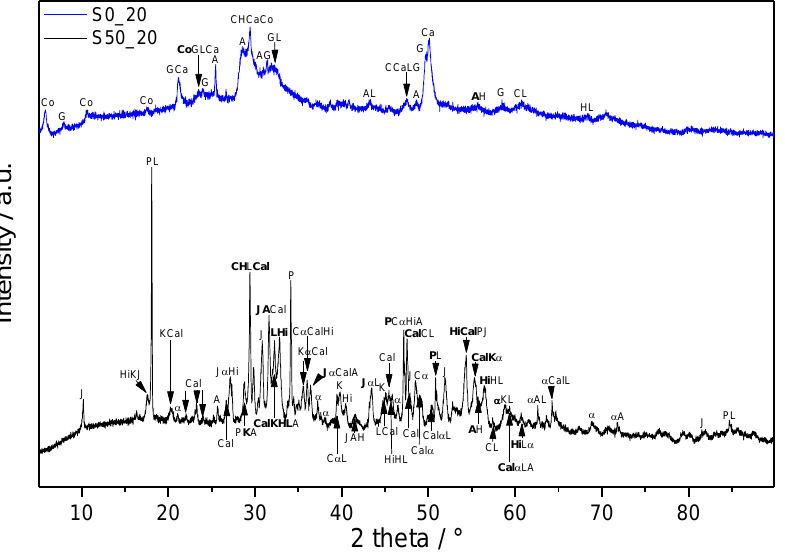
Figure 5. XRD patterns of samples cured at 2.0 MPa and 220 °C for 7 days. Abbreviations: α—α- dicalcium silicate hydrate (Ca 2 (SiO 3 OH)(OH), α-C 2 SH), A—anhydrite (CaSO 4 , CS ), C—calcite (CaCO 3 , C C̅ ), Ca—calcium hydrogen silicate (CaH 4 Si 2 O 7 , CS 2 H 2 ), Cal—calciochondrite (Ca 5 (SiO 4 ) 2 (OH) 2 , C 5 S 2 H), Co—cowlesite (CaAl 2 Si 3 O 10 · 6H 2 O, CAS 3 H 6 ), G—gyrolite